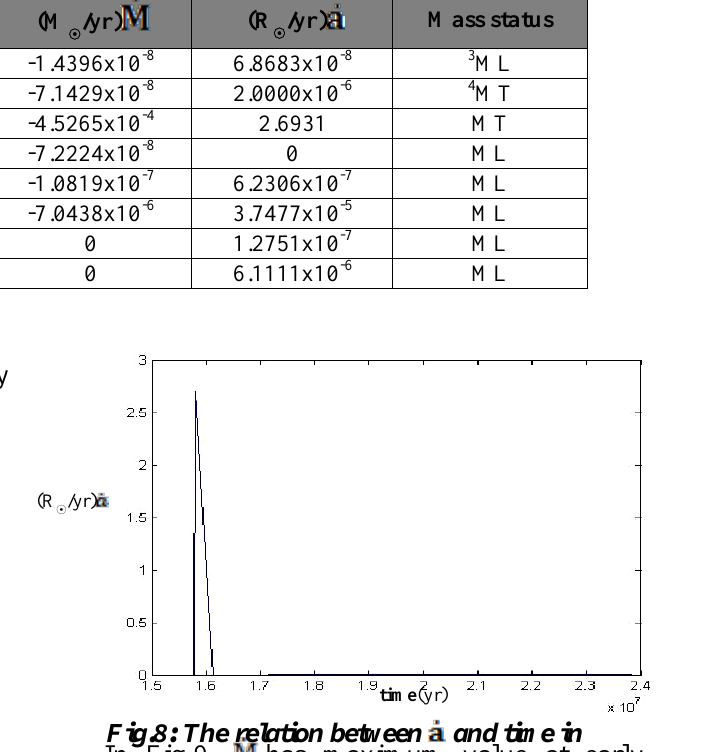
Fig.8: The relation between and time in binary star system (13+10) M